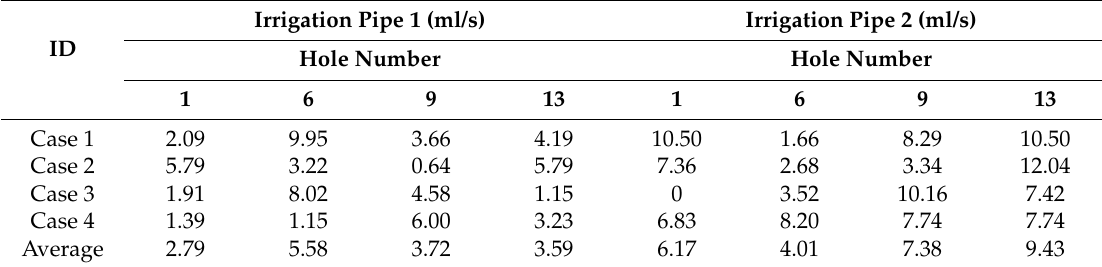
Table 10. Flow rate error of each irrigation